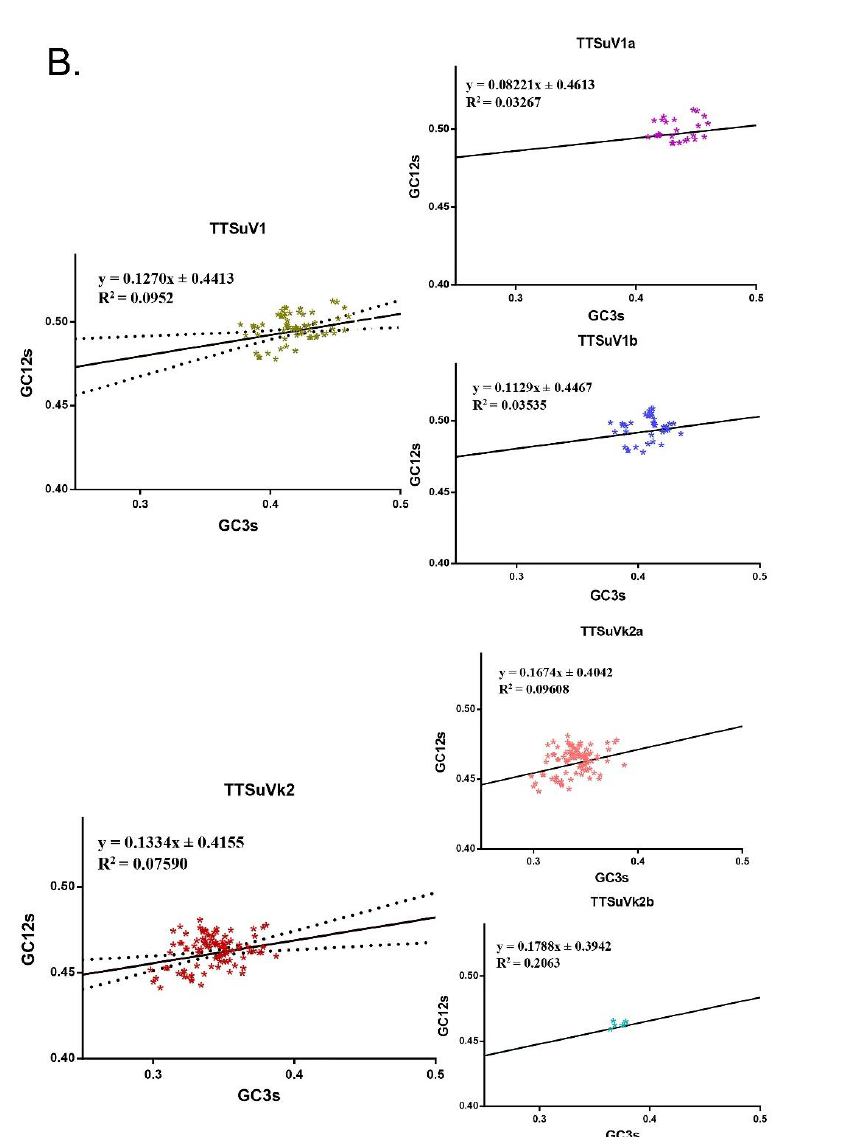
Figure 4. ( A ) ENC-plot representing GC3s plotted against the ENC of individual TTSuV species. ( B ) Neutrality analysis of individual TTSuV species, with GC12s plotted against GC3s. The dashed line indicates the 95% confidence interval. TTSuV1 is represented in green-brown, TTSuVk2 is represented in red, while TTSuV1a, TTSuV1b, TTSuVk2a, and TTSuVk2b are represented in purple, blue, pink, and green,